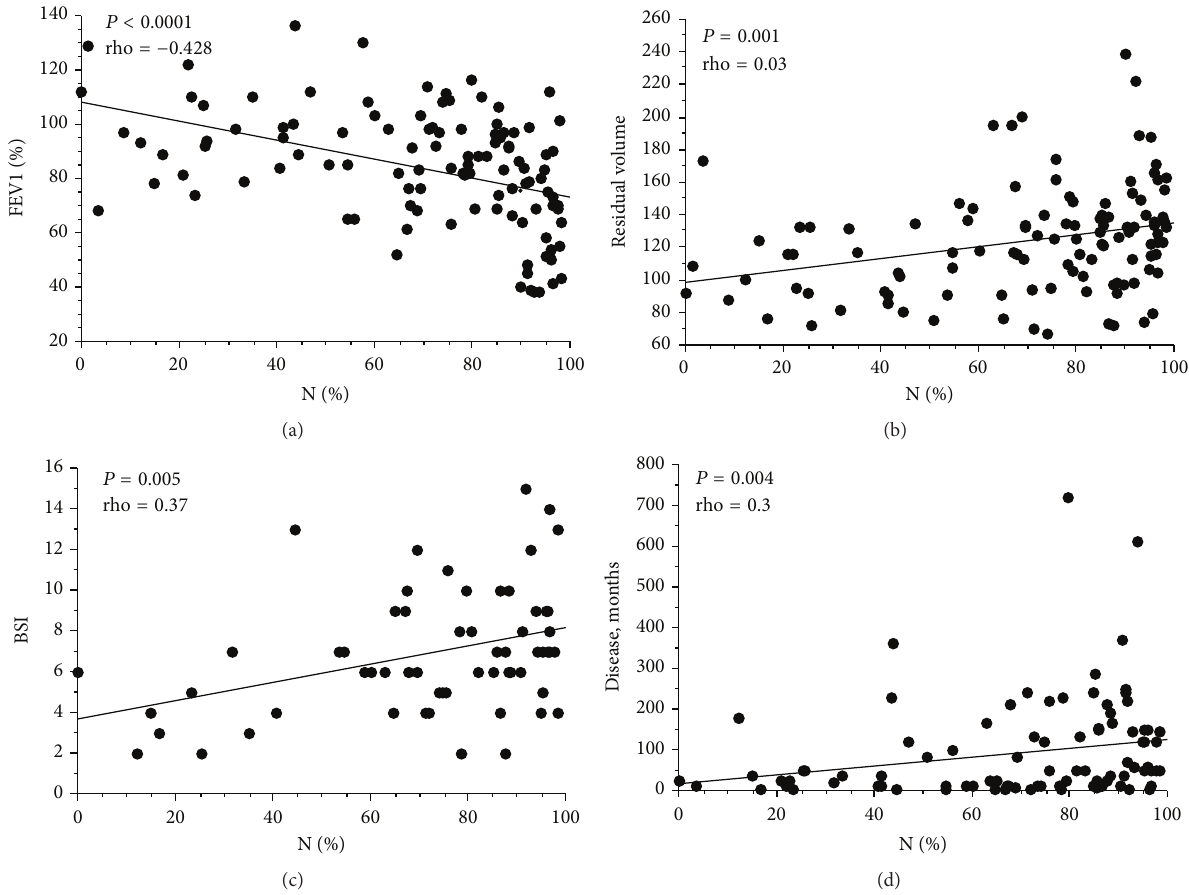
Figure 1: Correlation between neutrophils % in induced sputum and (a) FEV1, % predicted, (b) residual volume, (c) BSI, and (d) months between diagnosis of bronchiectasis and evaluation in the studied patients. Although these correlations are all statistically significant, the dispersion of the single data point is